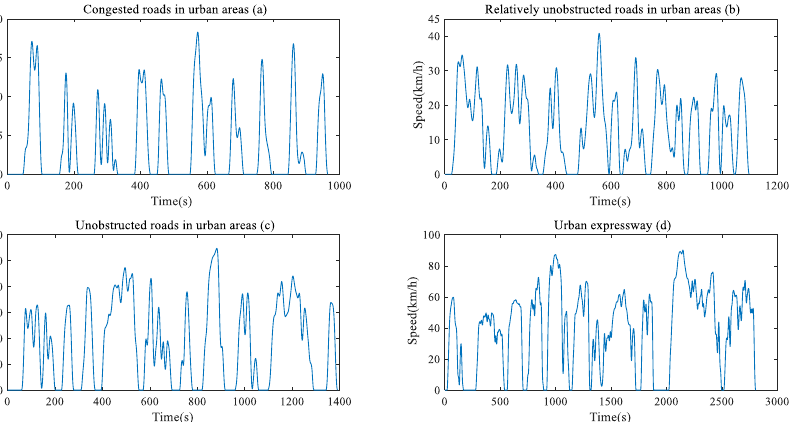
Figure 4. Four typical driving cycle curves. ( a ) Low speed cycle; ( b ) Medium speed ccycle; ( c ) Medium and high speed cycle; ( d ) High speed cycle.